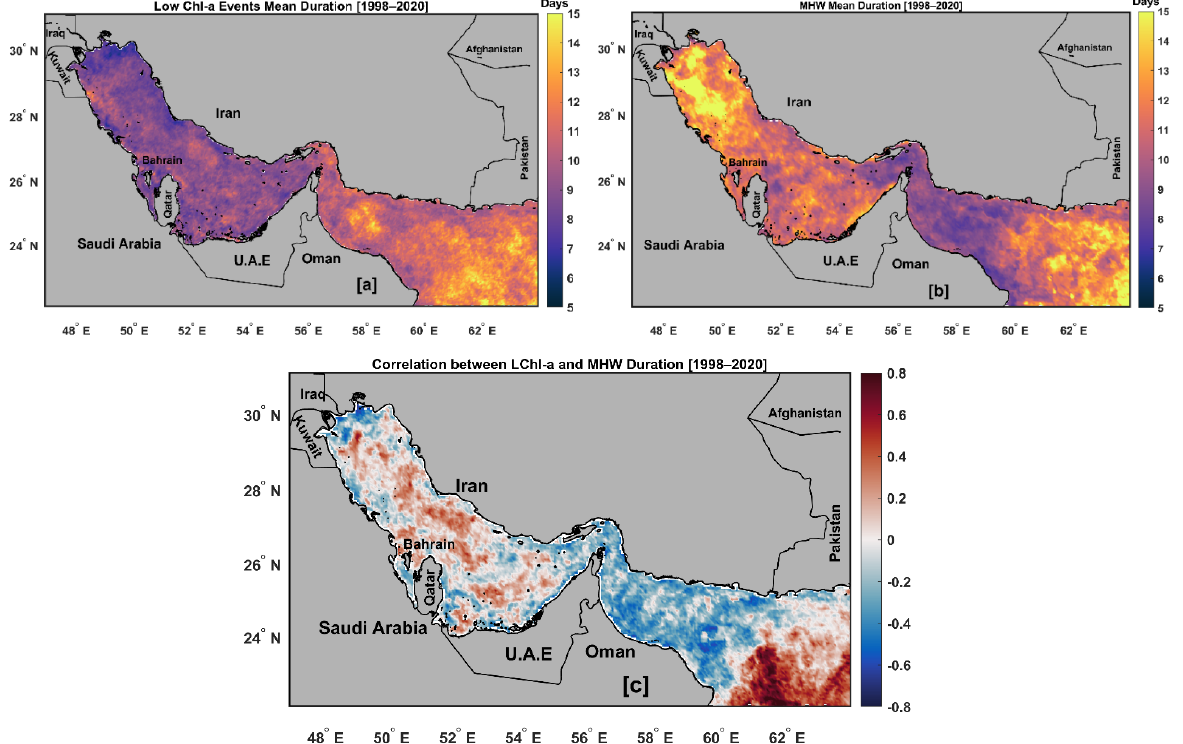
Figure 7. The spatial distribution of ( a ) LChl-a mean intensity (mg/m 3 ), ( b ) MHW mean intensity (°C), and ( c ) the spatial correlation map between them from 1998 to 2020 over the entire region.